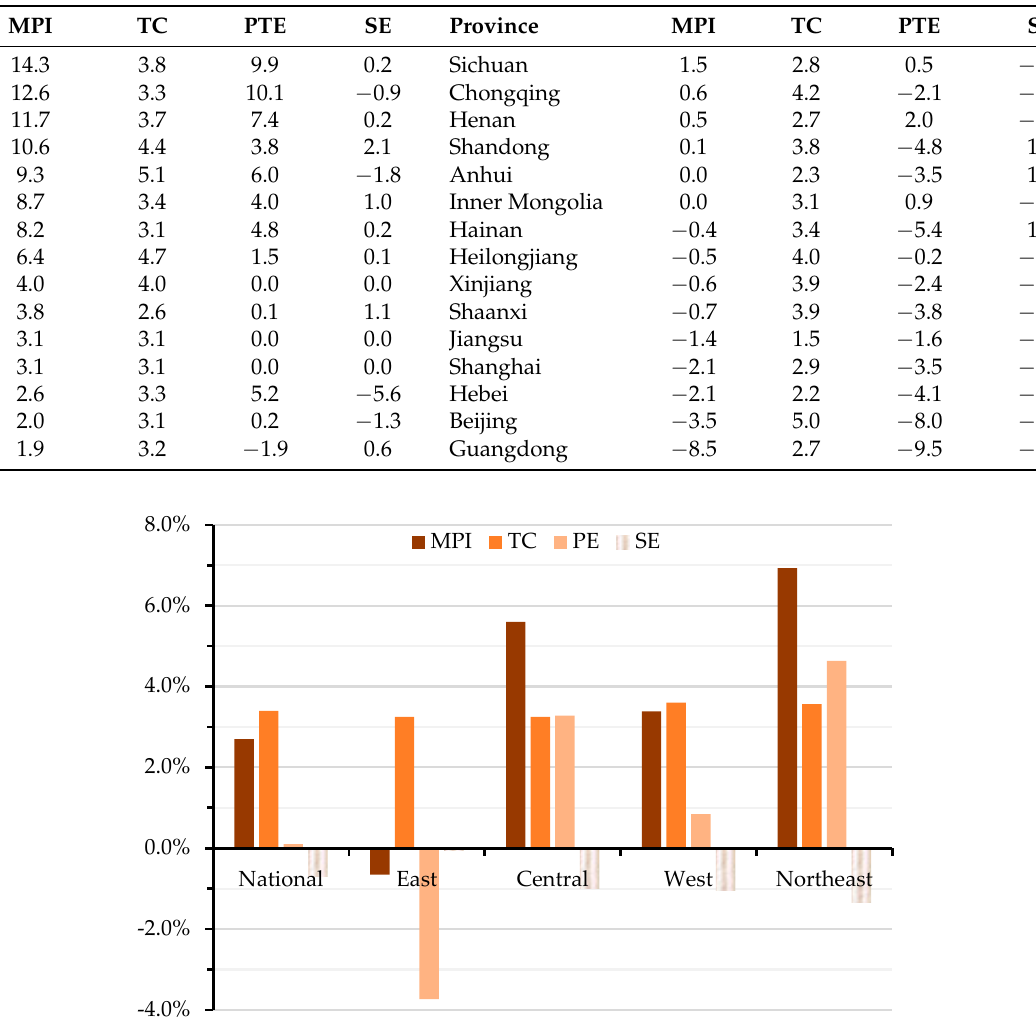
Figure 5. Drivers of SLUE growth by region.